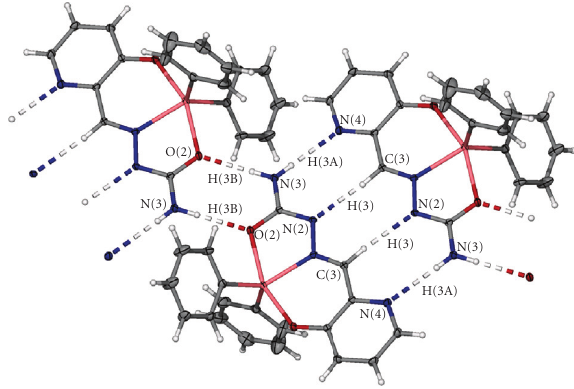
Figure 2: Arrangement of the intermolecular hydrogen bonds in 2. Thermal ellipsoids are drawn at the 40% probability level.